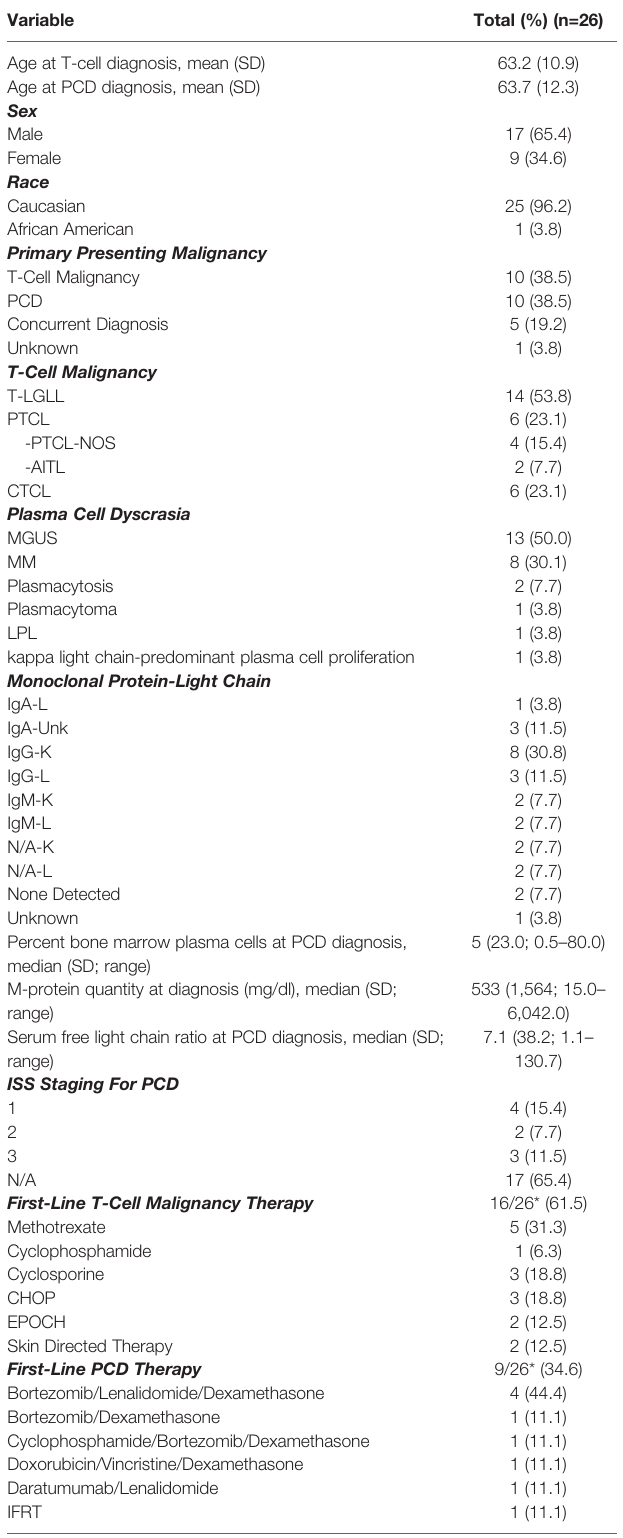
TABLE 1 | Baseline characteristics for all